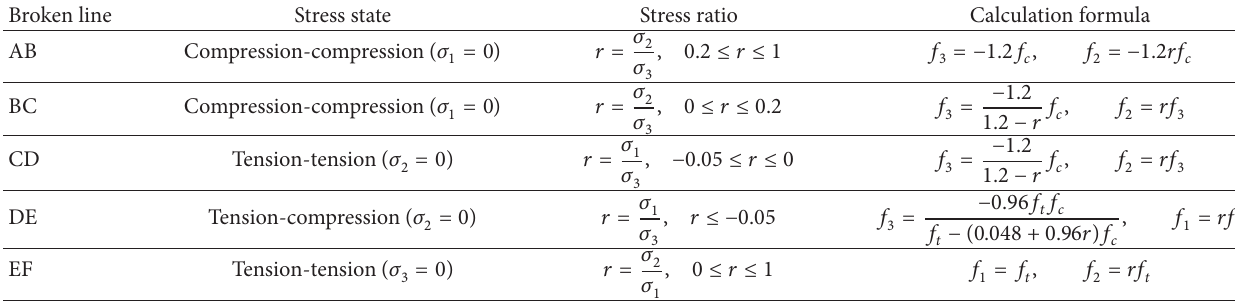
Table 6: Biaxial strength formula of the concrete